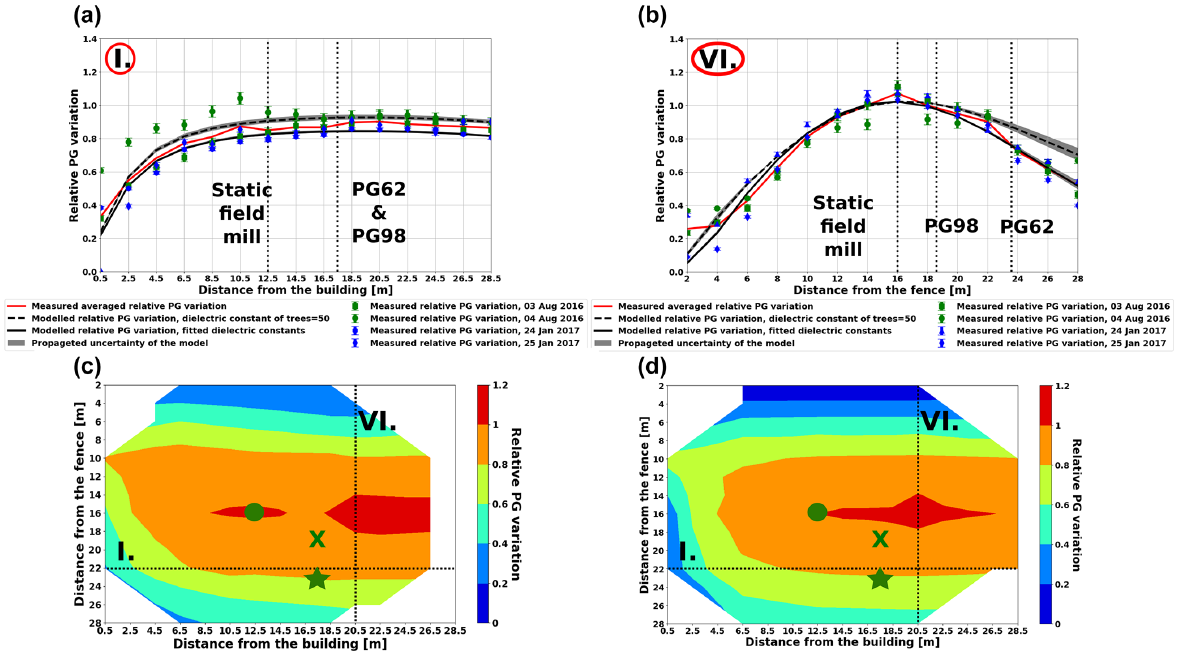
Figure 4. Measured and modelled relative PG variation along line I (a) and along line VI (b) . Measured (c) and modelled (d) relative PG variation interpolated over the grid of measurement points. Vertical dotted black lines in (a) and (b) denote the locations of the PG instruments. The green star, the green × , and the green dot in (c) and (d) mark the positions of the older radioactive apparatus (PG 62 ), the newer radioactive apparatus (PG 98 ), and the static field mill used as the reference point during the campaign measurements, respectively. See the site map in Fig. 1b for